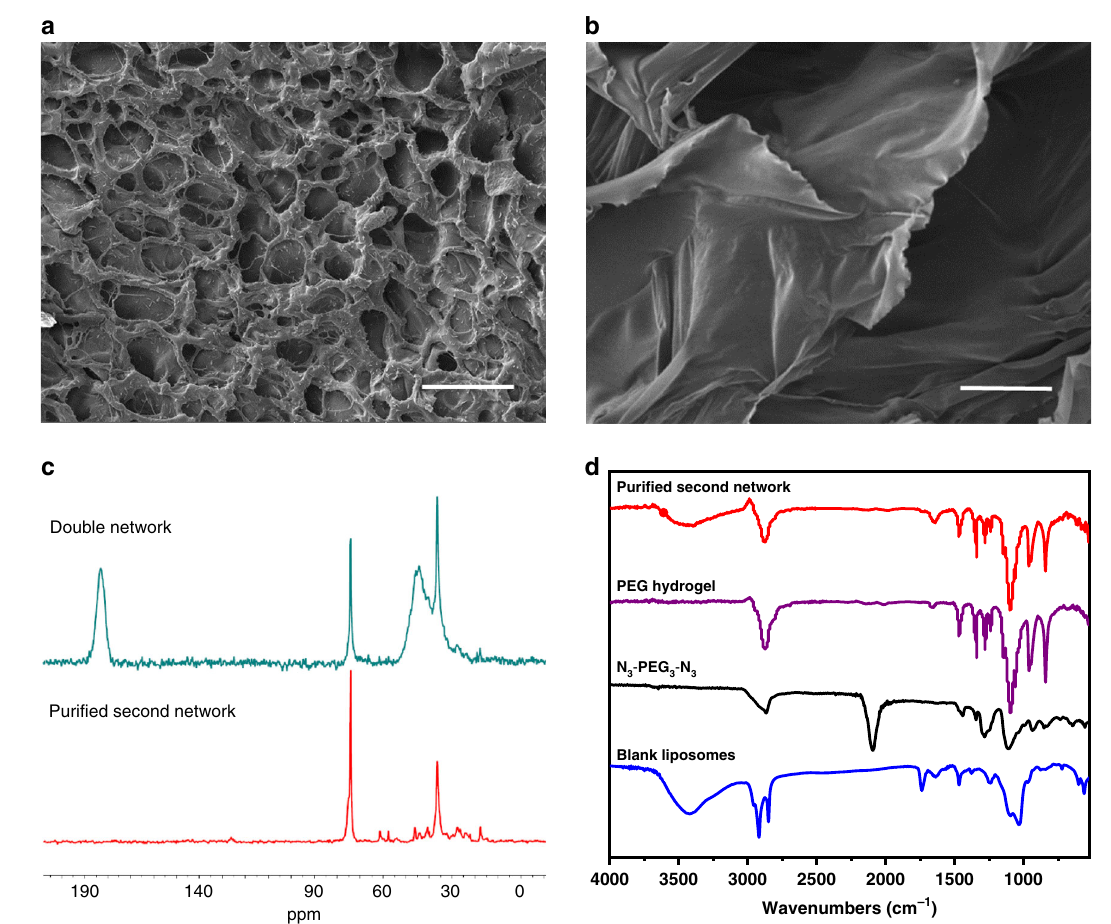
Fig. 6 Physical characterization of the second network. Scanning electron microscopy (SEM) images of the triggerable swelling-strengthening hydrogels (SSHs) ( a ) before and ( b ) after treating with GSH. Samples were lyophilized before SEM measurement. Scale bar, 50 μ m. Each test was repeated three times independently with similar results. c Solid-state 13C NMR spectra of the triggerable SSHs and the puri fi ed second network. The samples were lyophilized before analysis. d Fourier-transform infrared (FTIR) spectra of N3-PEG3-N3, blank liposomes, PEG hydrogel, and the puri fi ed second